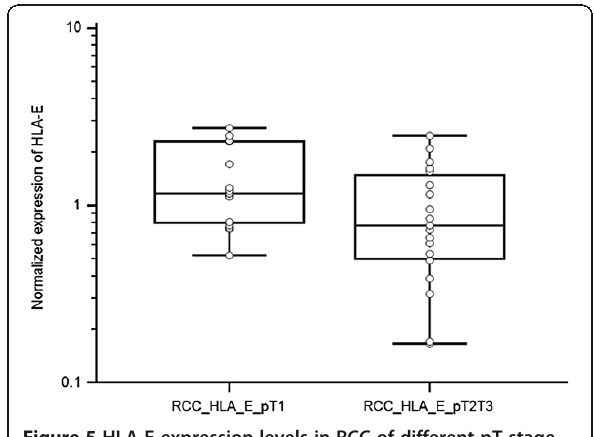
Figure 5 HLA-E expression levels in RCC of different pT stage (p=0.041, Mann – Whitney test) .